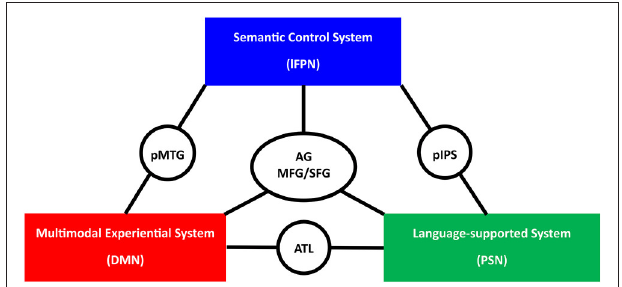
FIGURE 3 | The schematic presentation of the tri-network neurocognitive model of semantic processing. lFPN, left frontoparietal network; DMN, default mode network; PSN, perisylvian network; pMTG, posterior middle temporal gyrus; ATL, anterior temporal lobe; pIPS, posterior intraparietal sulcus; AG, angular gyrus; SFG/MFG, superior and middle frontal